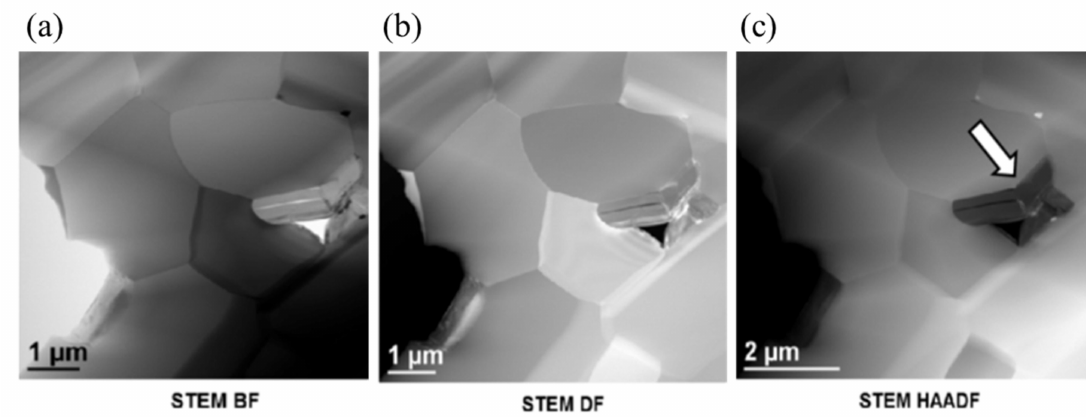
Figure 10. Hexoloy SiC. ( a ) STEM BF, ( b ) STEM DF, and ( c ) STEM HAADF images showing a graphite inclusion (arrow) containing a few smaller oxide inclusions. Figure 10 reprinted from [122] with